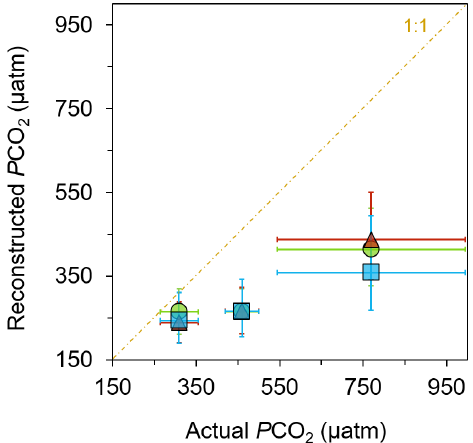
Figure 5. Reconstructed p CO 2 from general algal biomarkers. p CO 2 reconstructed from the δ 13 C of loliolide (triangle), phytol (circle), and cholesterol (square) in June-collected sediments versus the actual p CO 2 measured at each location (Agostini et al., 2018; Harvey et al.,